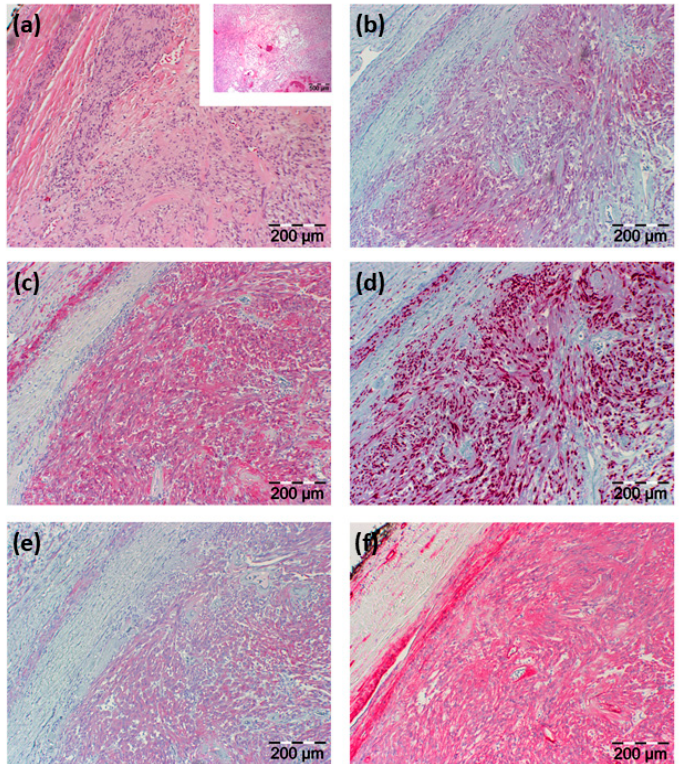
Figure 3. H&E histology and immunohistochemical staining results. ( a ) H&E staining illustrated in two different magnifications; the smaller image with a lower magnification shows regressive areas of the tumor; in ( b – f ) immunohistochemical staining is shown directed against ( b ) NSE, ( c ) S100, ( d ) Sox10, ( e ) CD56, and ( f ) collagen type IV. Section sizes are indicated by a scale bar.